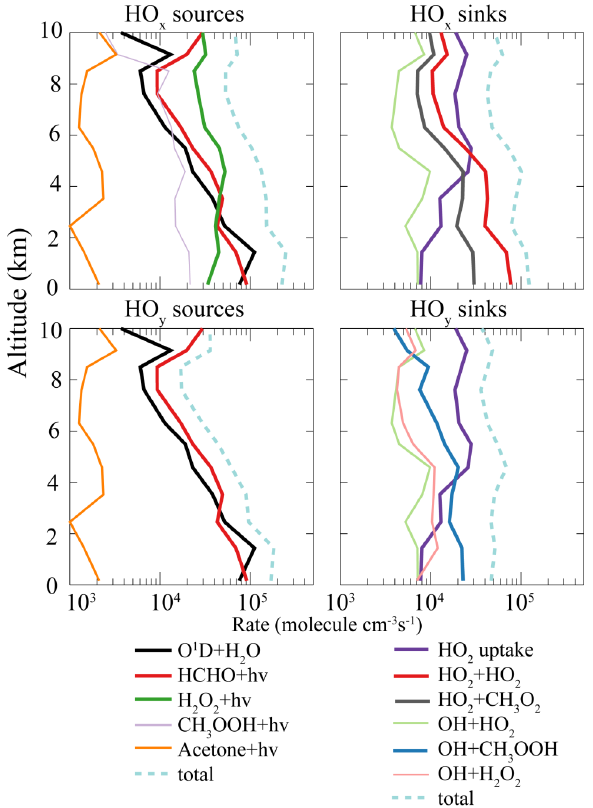
Figure 5 Median vertical profiles of major HO x and HO y sources and sinks computed Fig. 5. Median vertical profiles of major HO x and HO y sources from observed tropospheric concentrations in ARCTAS (April 2008). Values are and sinks computed from observed tropospheric concentrations in instantaneous rates. Only important processes are shown. Gas-phase rate constants are ARCTAS (April 2008). Values are instantaneous rates. Only impor- from JPL06 and IUPAC06. HO 2 uptake by aerosol is computed with a reaction tant processes are shown. Gas-phase rate constants are from JPL06 probability γ (HO 2 → products) from Thornton et al. [2008]. Stratospheric data are and IUPAC06. HO 2 uptake by aerosol is computed with a reaction excluded as described in the text. probability γ (HO 2 → products) from Thornton et al. (2008). Strato- spheric data are excluded as described in the